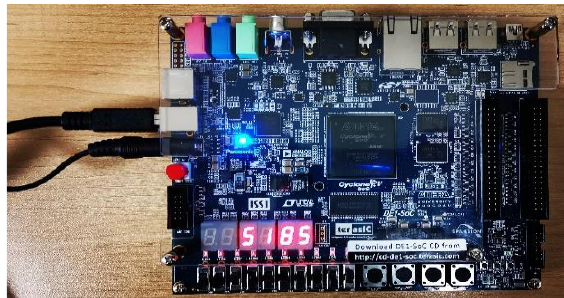
Fig. 7 . The value of the thermal peak available on